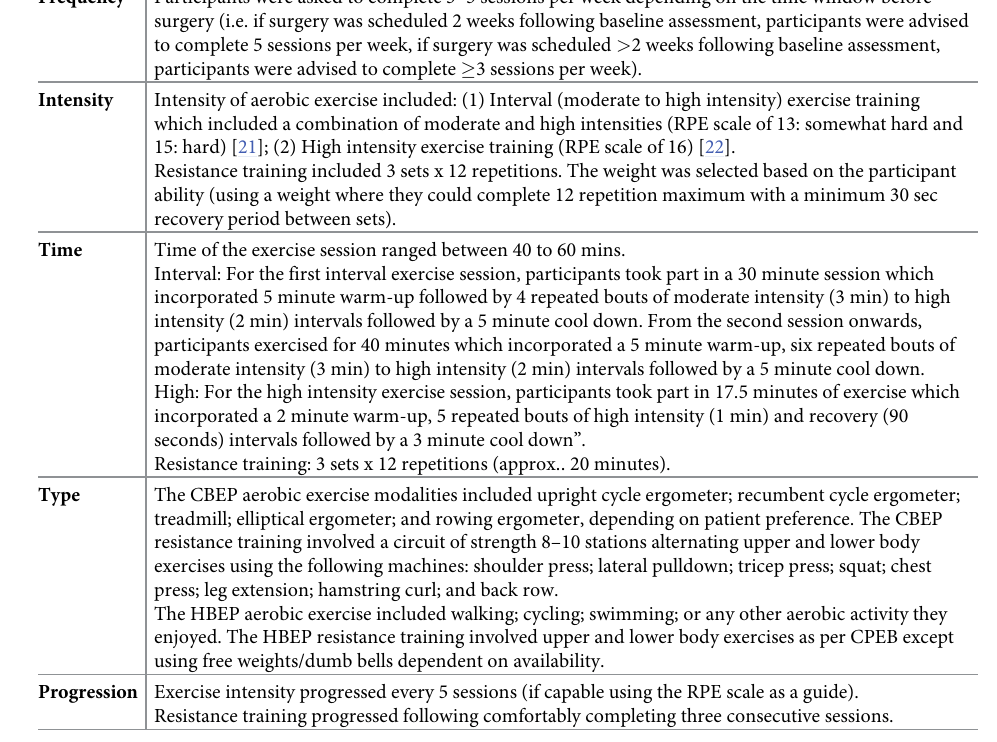
Table 1. Exercise training prescription described using the FITT principle (frequency, intensity, time, type) and progression.